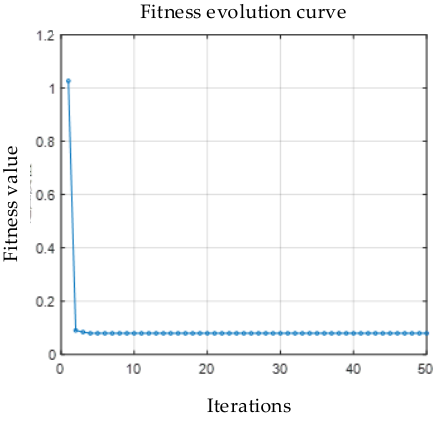
Figure 6. The parameter identification optimization process.